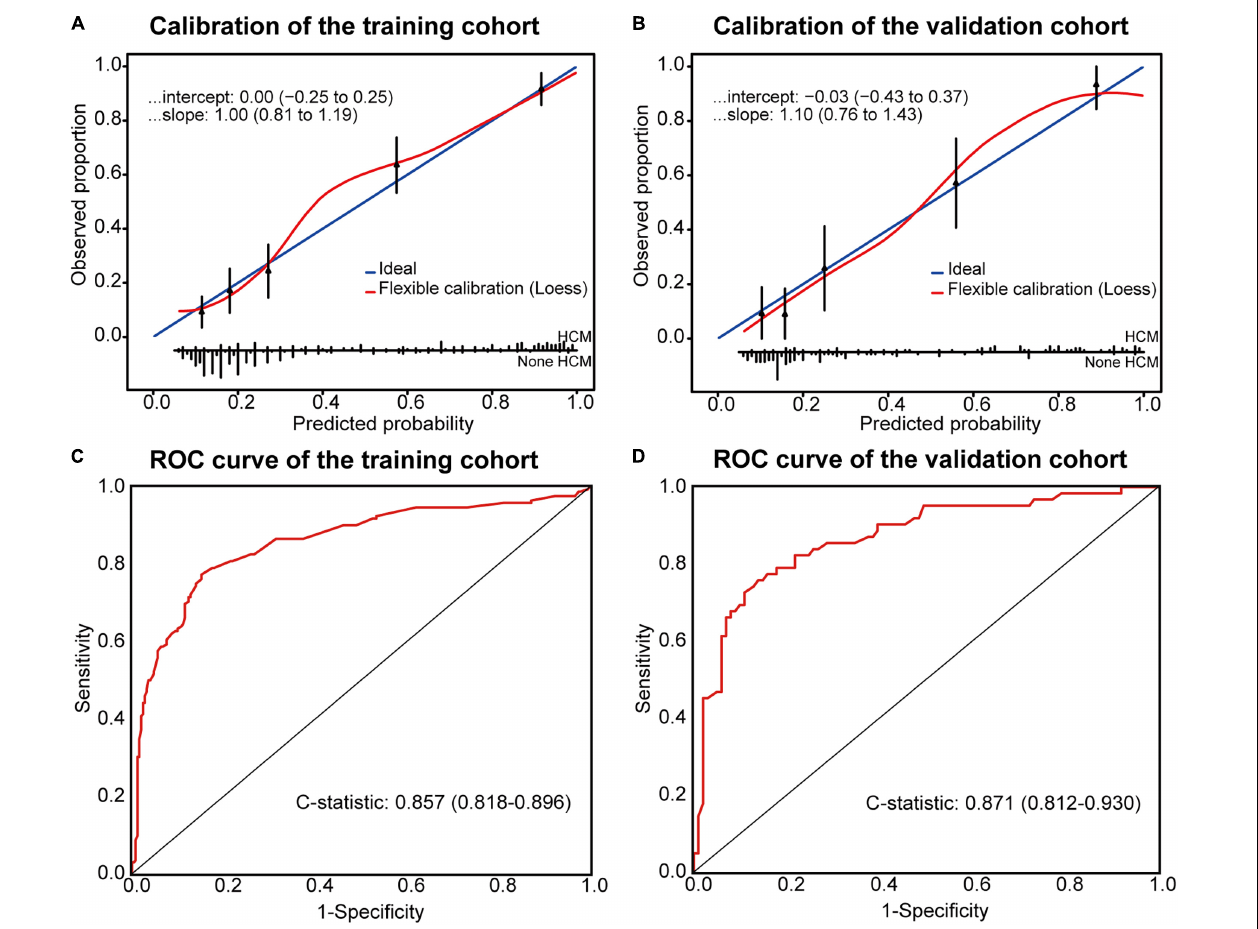
FIGURE 2 | Calibration plots and ROC curve for the Model. Calibration plots between predicted and observed HCM in the training (A) and temporal validation (B) cohorts. The 45 ◦ blue line represents a perfect prediction, and the red line represents the predictive performance of the model. ROC curve of the model in the training (C) and temporal validation (D)